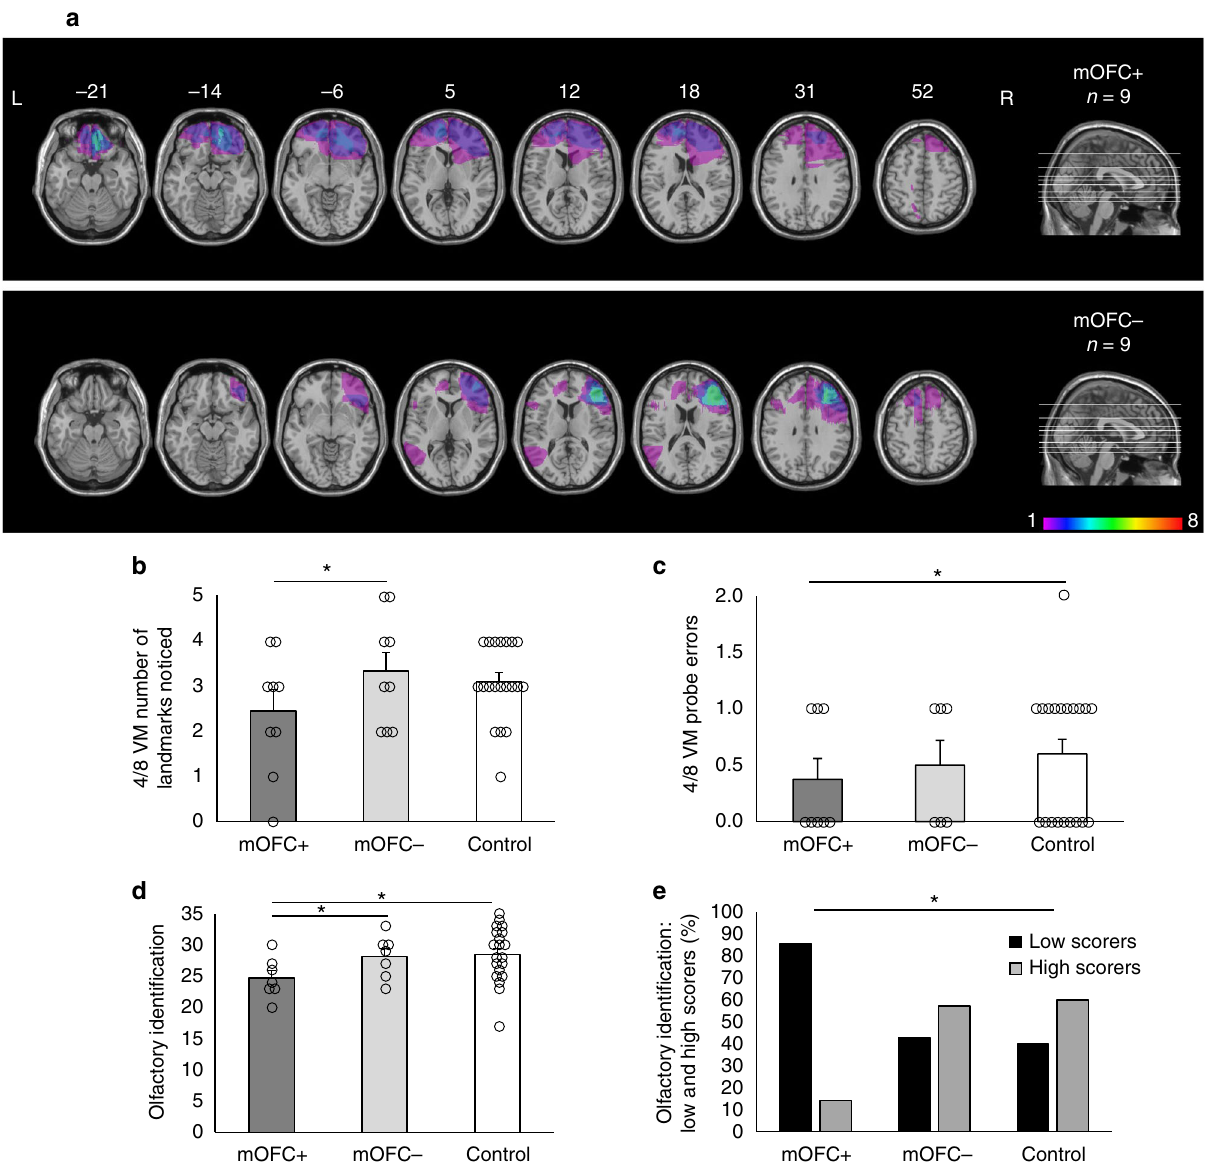
Fig. 5 Patients with medial orbitofrontal cortex (mOFC) damage show reduced spatial memory. a Axial slices and midsagittal view of the ICBM52 MNI brain depicting the extent of the lesion overlap for patients whose frontal lobe lesions encompass the mOFC (mOFC + ; top) and patients whose frontal lobe lesions do not encompass the mOFC (mOFC-; bottom). The numbers above the axial slices indicate their z coordinates in MNI space. The colors indicate the degree to which lesions overlap within each group, as indicated by the color scale, which ranges from 1 to 8 patients. b In the 4/8 VM, the mOFC + group noticed fewer landmarks in the environment compared to the mOFC- group (mean difference = − 1.17, Bootstrap BCa 95% CI [ − 2.20, − 0.27]). c The mOFC + group also made fewer errors on the probe trial compared to the control group (mean difference = − 0.24, Bootstrap BCa 95% CI [ − 0.55, − 0.02]). d The mOFC + group exhibited worse olfactory identi fi cation than both the mOFC- group (mean difference = − 4.99, Bootstrap BCa 95% CI [ − 8.54, − 1.09]) and the control group (mean difference = − 3.70, Bootstrap BCa 95% CI [ − 6.02, − 1.12]). e We categorized participants as low (black bars) or high (gray bars) scorers on the olfactory indenti fi cation task according to the median across all groups (median = 27.5). The mOFC + group included more low scorers than the control group, p < 0.05 (Fisher ’ s exact test). These results indicate that mOFC damage affects both spatial memory and olfaction, as it is is associated with a lesser reliance on landmarks and worse olfactory identi fi cation. Error bars indicate the standard error of the mean. *indicates signi fi cance based on bootstrapped bias-corrected 95% con fi dence intervals. L Left, R